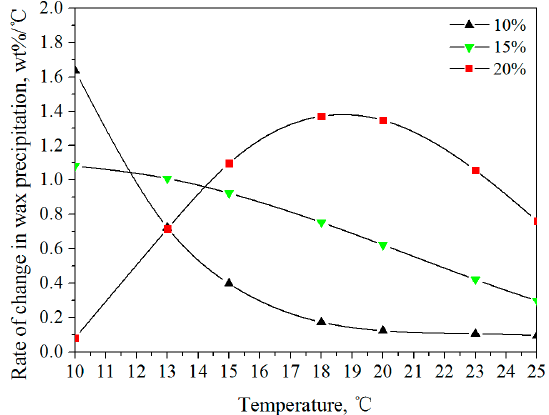
Figure 7. The rate of change in wax precipitation at different temperatures.